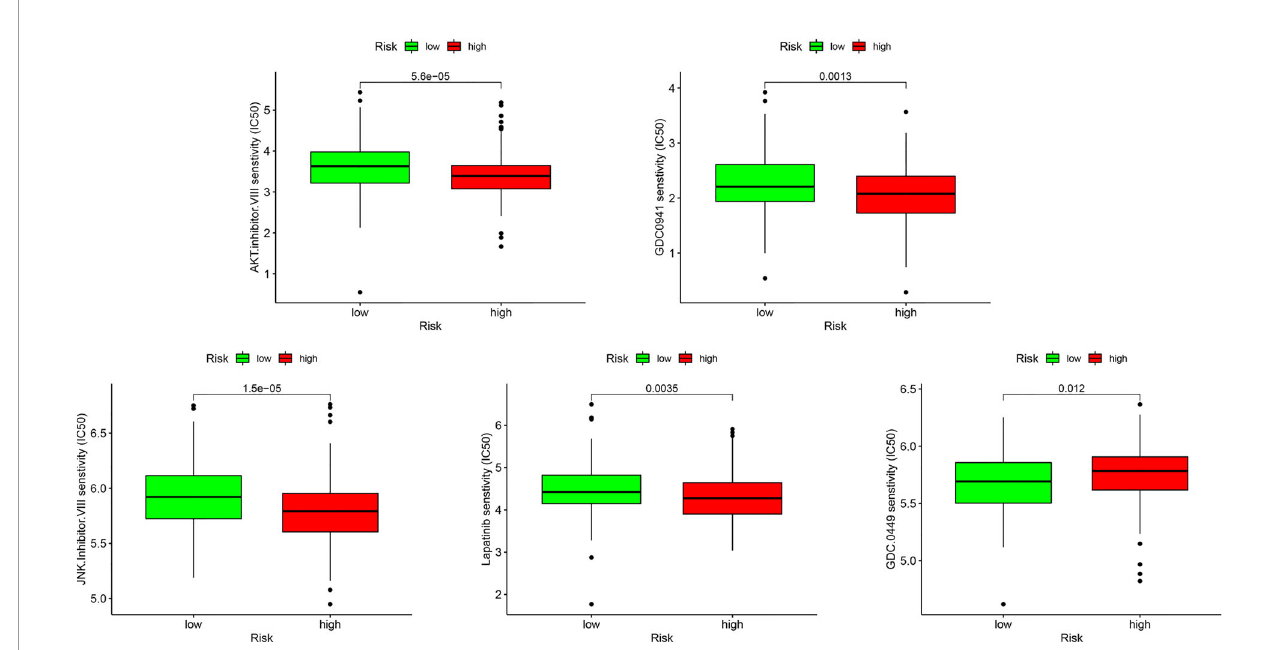
FIGURE 10 | The sensitivity difference of multiple targeted inhibitors within different risk groups, including AKT inhibitor VIII, GDC0941, JNK Inhibitor VIII, Lapatinib, and